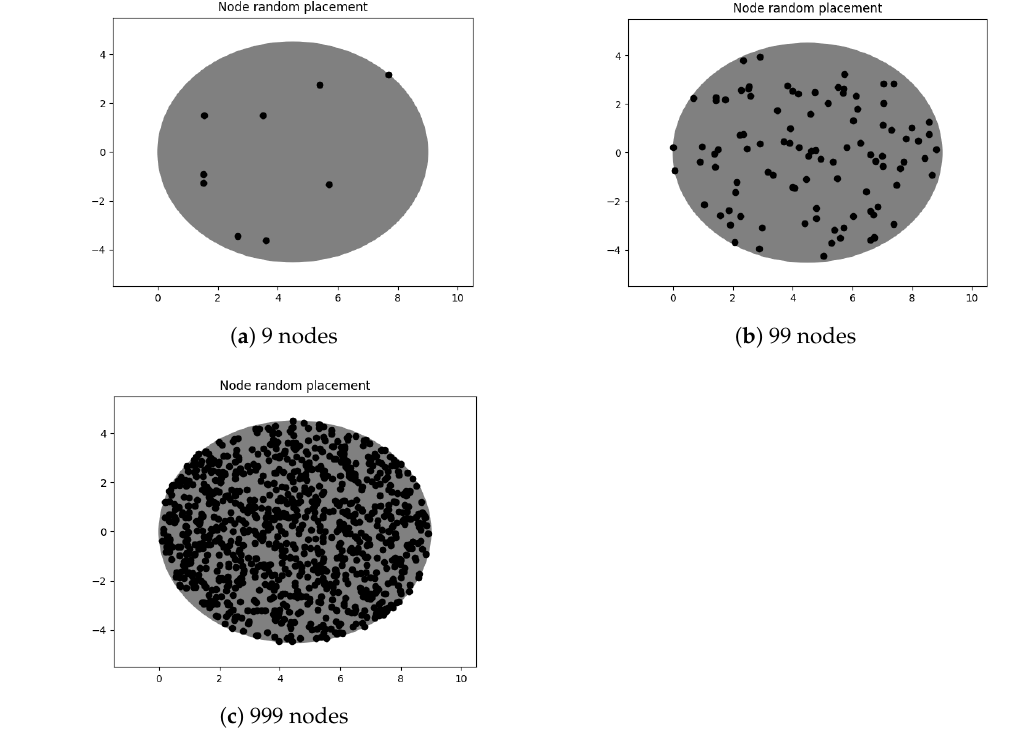
Figure 4. Random placing of ( a ) 9, ( b ) 99 and ( c ) 999